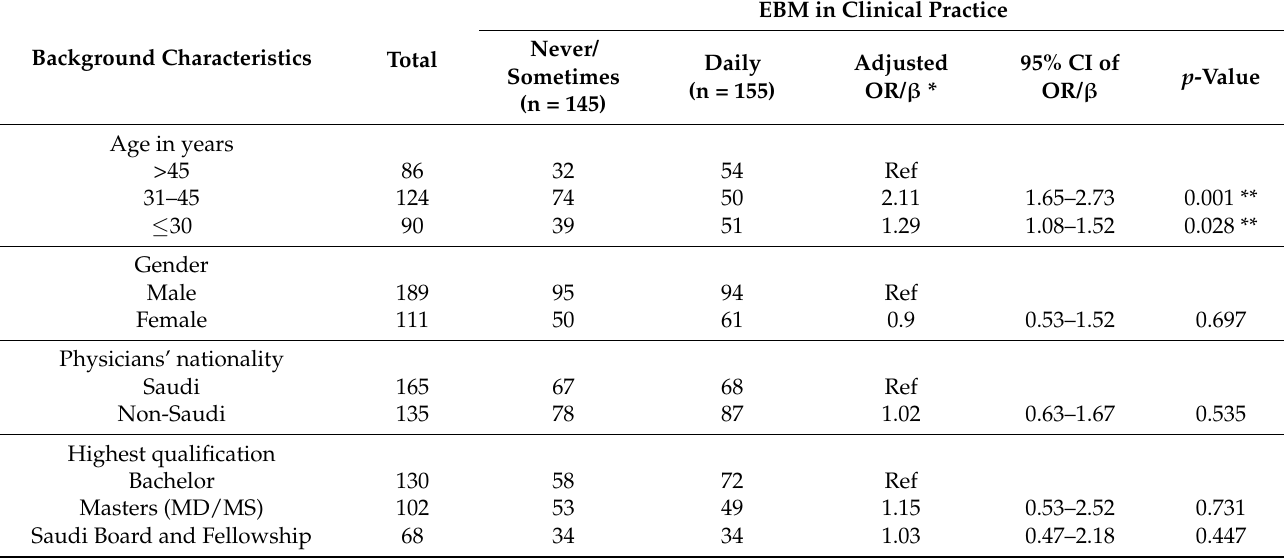
Table 6. Predictors for including EBM in daily clinical practice analyzed by binomial logistic regres- sion analysis (n =